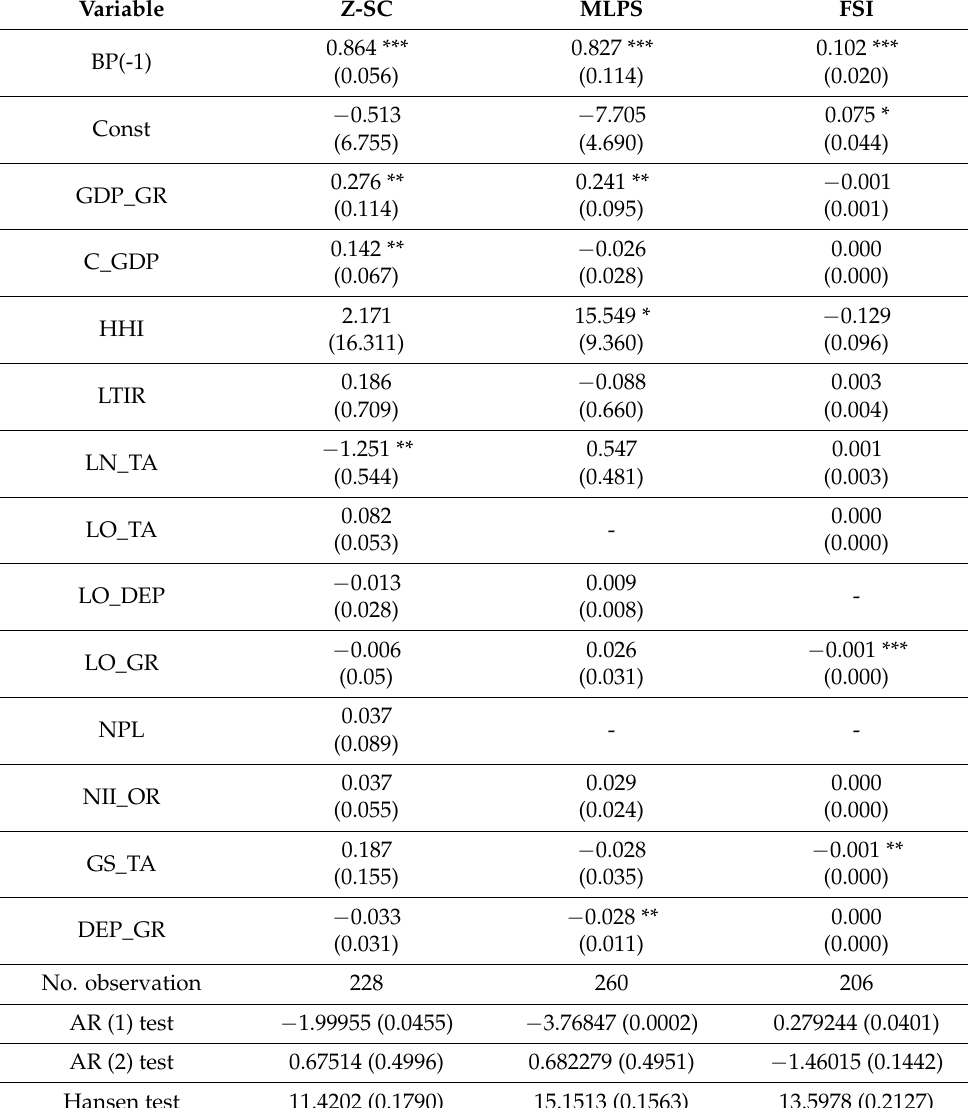
Table 7. Panel model results: risk-based stability and performance indicators (Z-score, MLPS, and